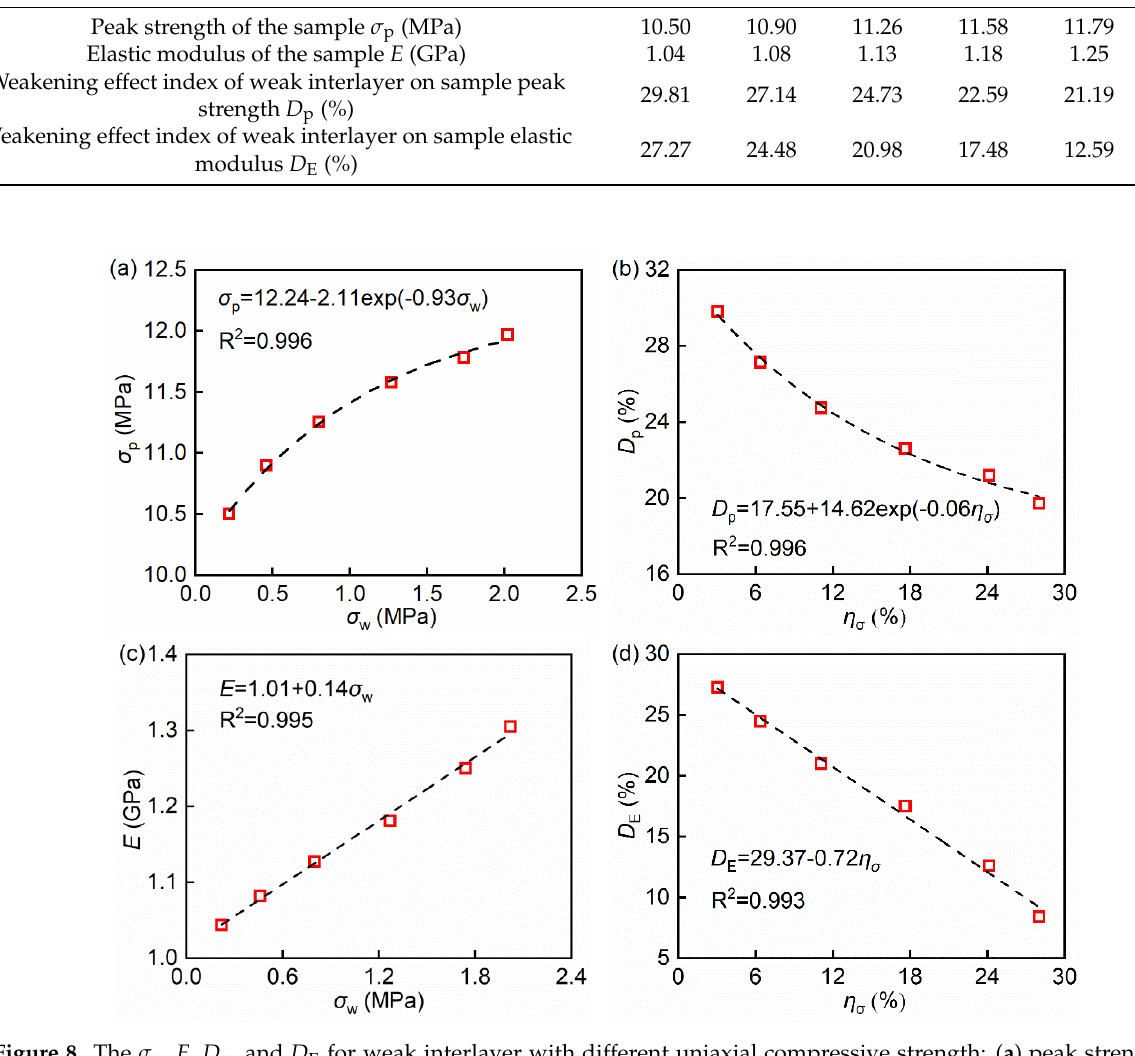
Table 5. The σ p , E , D p , and D E for weak interlayer with different uniaxial compressive strength. Uniaxial Compressive Strength of Weak Interlayer σ w (MPa)